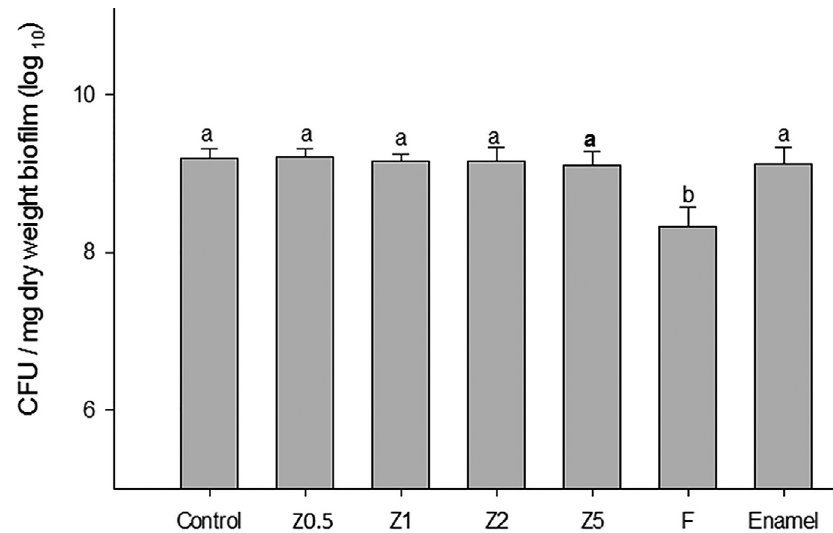
Figure 2- Test of S. mutans UA159 accumulation after 3 days of biofilm formation under conditions exposure to 1% sucrose